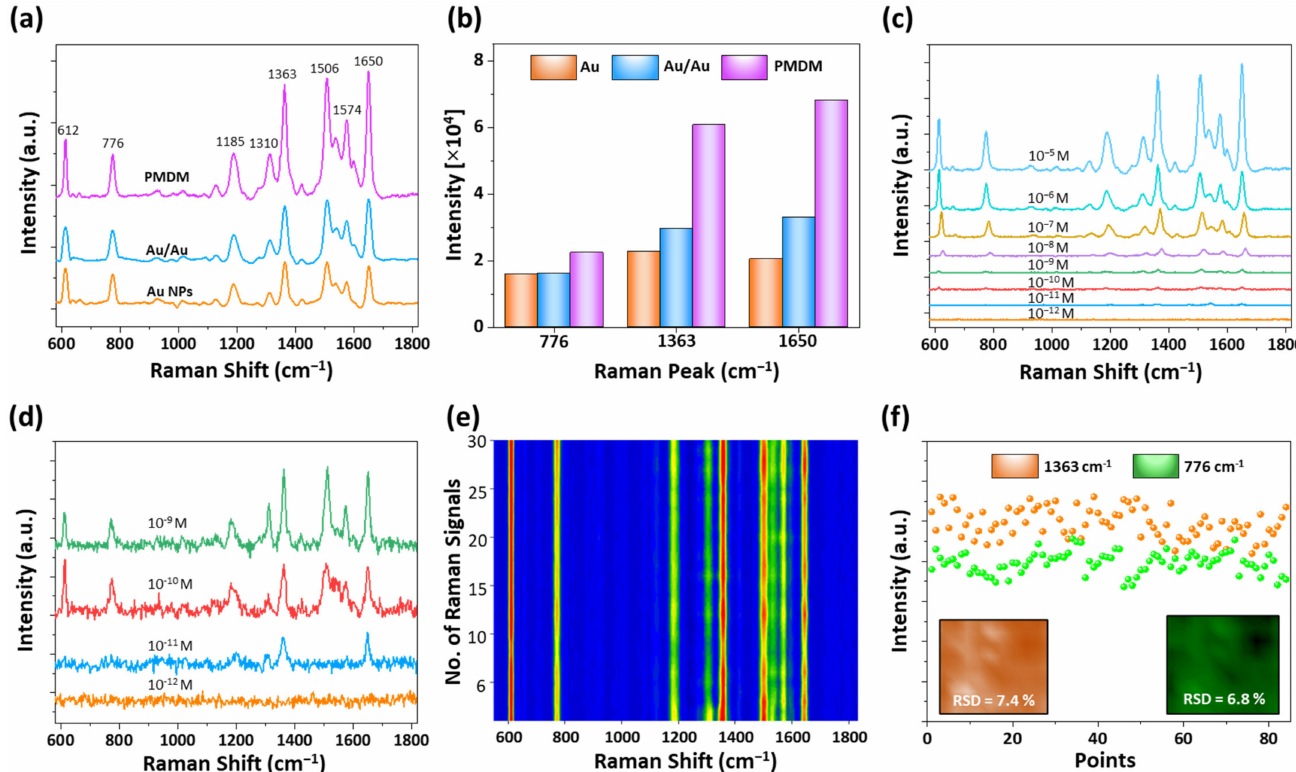
Figure 4. ( a ) Comparison of the SERS spectra of R6G molecules (10 − 6 M) on Au, Au/Au, and PMDM hybrid nanostructure-based SERS substrates. ( b ) Corresponding plot of intensity at Raman peaks of 776, 1363, and 1650 cm − 1 . ( c ) SERS spectra of R6G molecules on PMDM hybrid nanostructure-based SERS substrate with different concentrations ranging from 10 − 5 to 10 − 12 M. ( d ) Magnified SERS spectra of R6G with low concentrations showing the distinct Raman peaks. SERS uniformity and reproducibility of the PMDM hybrid nanostructure substrate. ( e ) SERS contour maps of 30 spots and ( f ) plot of Raman intensities of 776 and 1363 cm − 1 randomly selected from SERS mapping in an area of 10 µ m × 10 µ m. (Insets) SERS intensity mapping of 776 and 1363 cm − 1